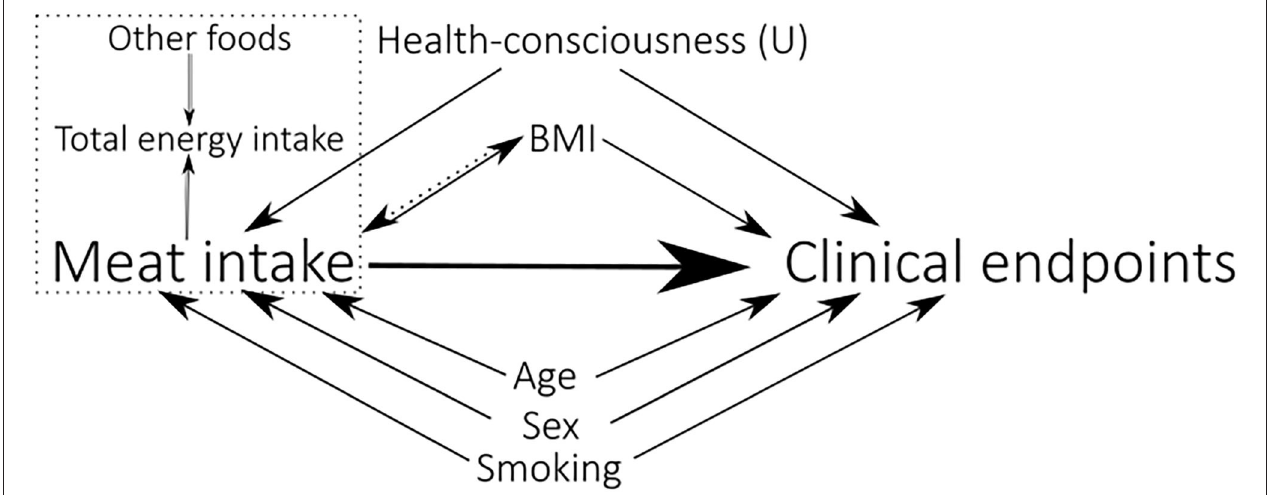
FIGURE 2 | A directed acyclic graph illustrating the model building process, representing the causal assumptions that were made. The variables pointing toward both Meat intake and Clinical endpoints (all-cause mortality, AMI, cancer, and GI-cancer), are considered confounders for these associations. The (U) indicates that the variable is unmeasured. BMI is modeled both as a mediator (Model 1) and a confounder (Model 2). A dashed rectangle encompasses variables occurring at the same time.